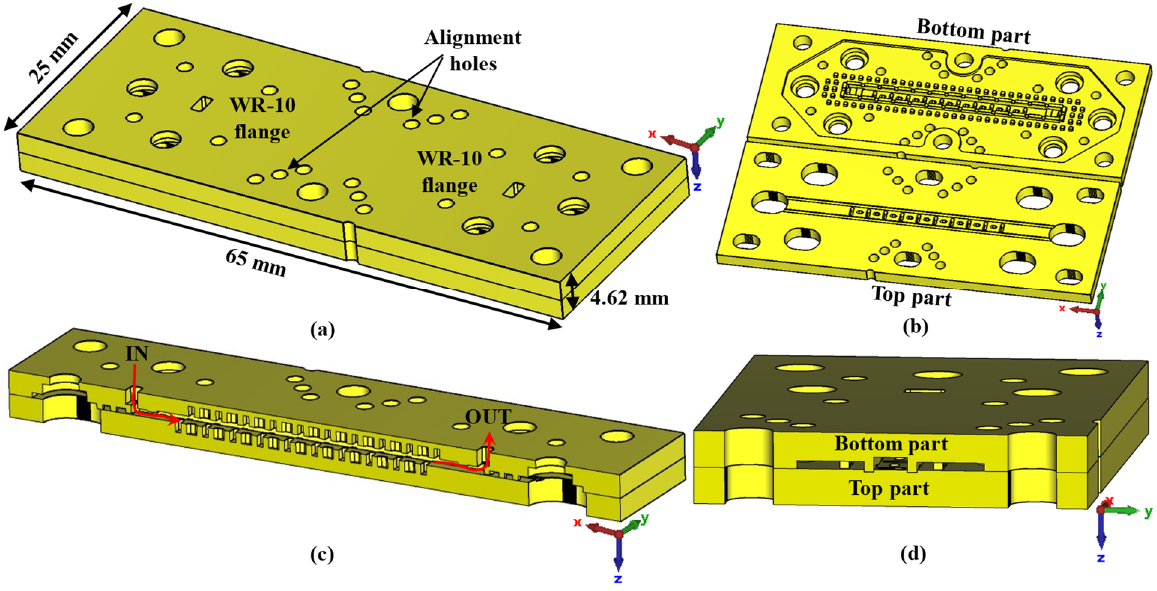
Figure 28. 3D model of the final filter designed for manufacturing. ( a ) Complete assembled design, ( b ) interior view of the two pieces that form the filter, ( c ) longitudinal cut of the filter and ( d ) transversal cut.